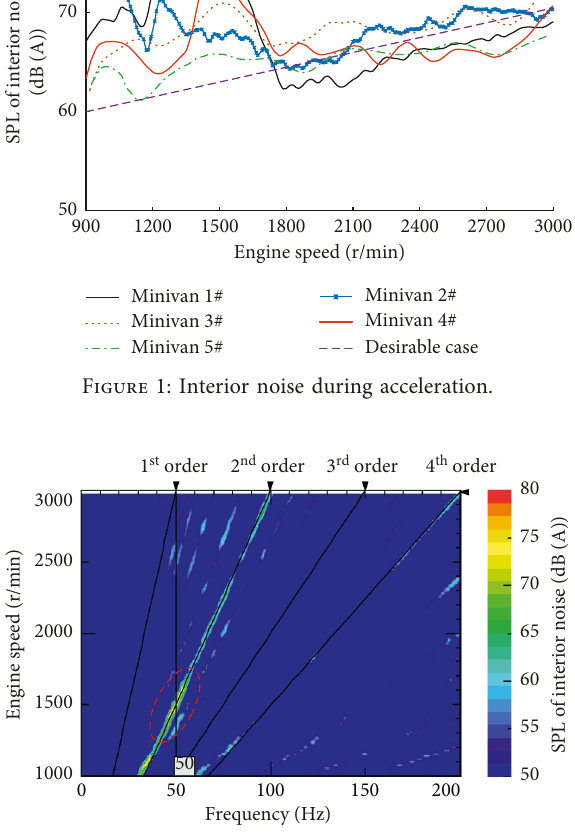
Figure 2: Colormap of minivan 4# interior noise during